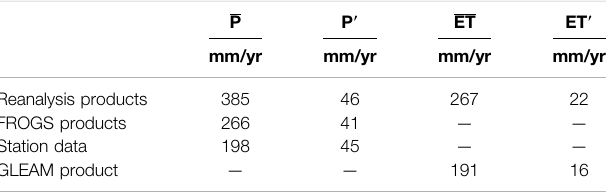
P and ET are calculated as the meanvalue ofthe temporal averageof the timeseries for the whole plateau for the whole study period (1979 – 2015) for each product. P ′ and ET ′ arecalculatedastheaverageofthestandarddeviationofeachannualtimeseriesforthe whole study period.